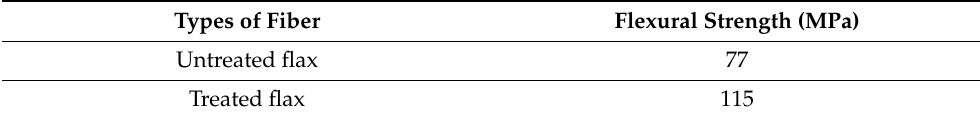
Table 11. Flexural strength of untreated and treated flax reinforced PP composites.